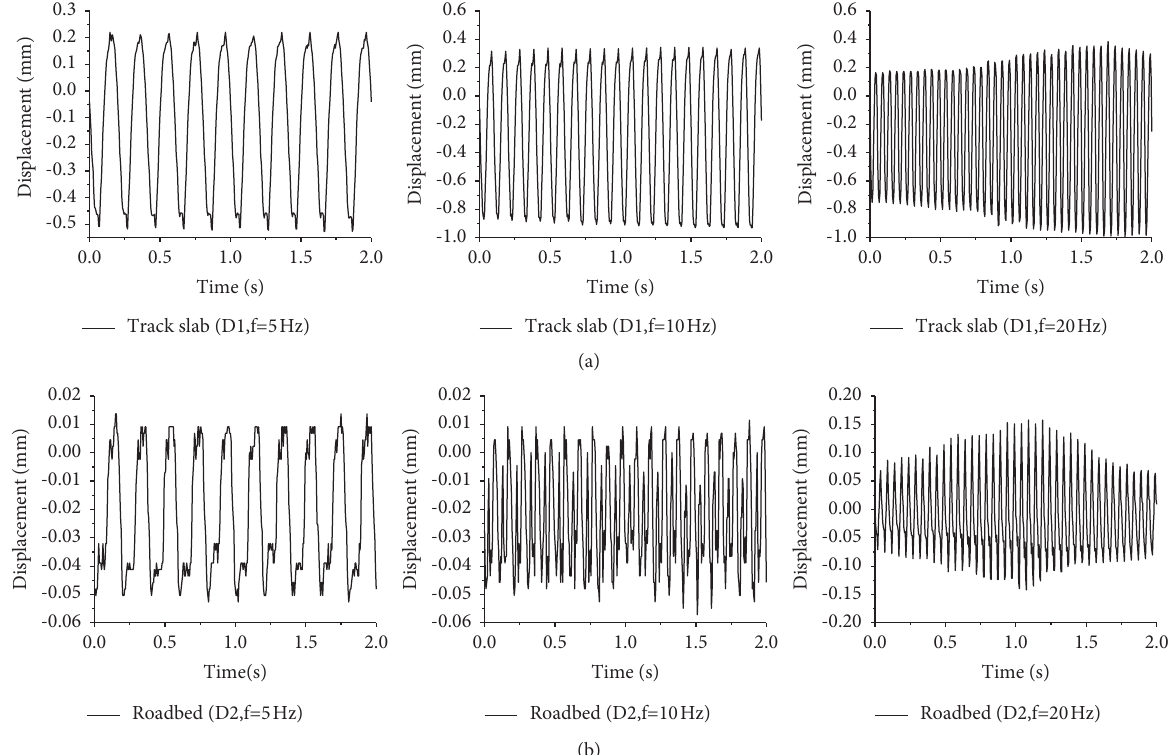
Figure 5: Time history curves of dynamic displacement of track slab and roadbed for three loading frequencies. (a) Track slab (D1, f � 5Hz, 10Hz, and 20Hz). (b) Roadbed (D2, f � 5 Hz, 10Hz, and 20Hz).